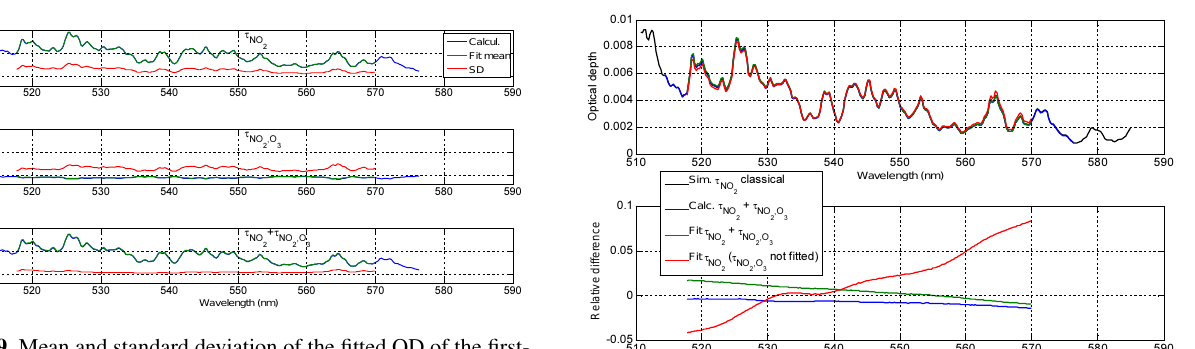
Figure 9. Mean and standard deviation of the fitted OD of the first- order NO 2 term (top), second-order cross-correlative term between ozone and NO 2 (middle), and the sum of both terms (bottom). For a statistical evaluation, the analysis is performed for the simulated limb spectrum at TH = 19.83km with 1000 different random Gaus- sian noise spectra added (similar as for Fig. 8). Additionally, the re- spective terms as calculated from the simulated effective light paths are included for comparison.